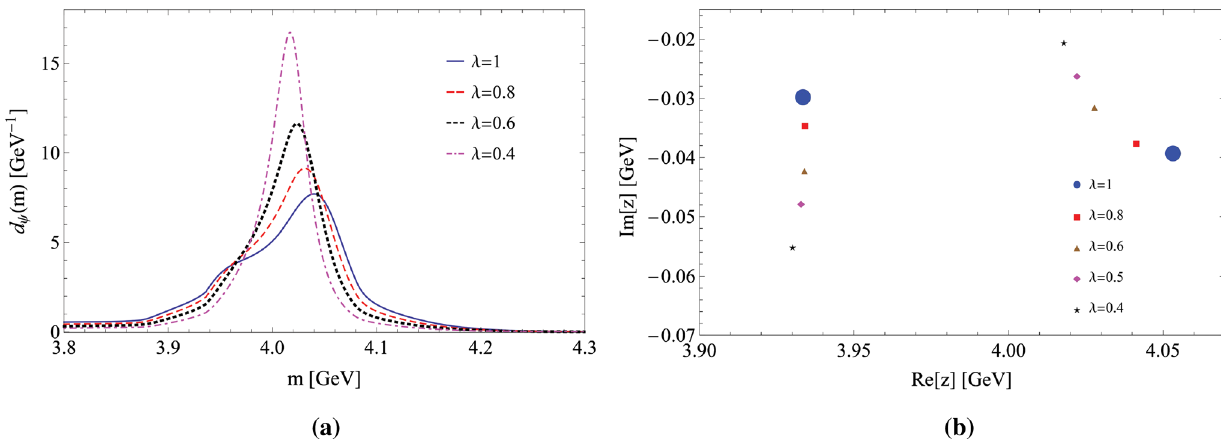
Fig. 3 Study of the changing of the spectral function ( a ) and pole movement in the complex plane ( b ) for different values of λ . The used parameters for the plots are: g ψ DD = 39 . 84, g ψ D ∗ D = 3 . 44 GeV − 1 , g ψ D ∗ D ∗ = 1 . 85, M ψ = 4 . 007 GeV and Gaussian form factor F (cid:11) with (cid:11) = 0 . 42